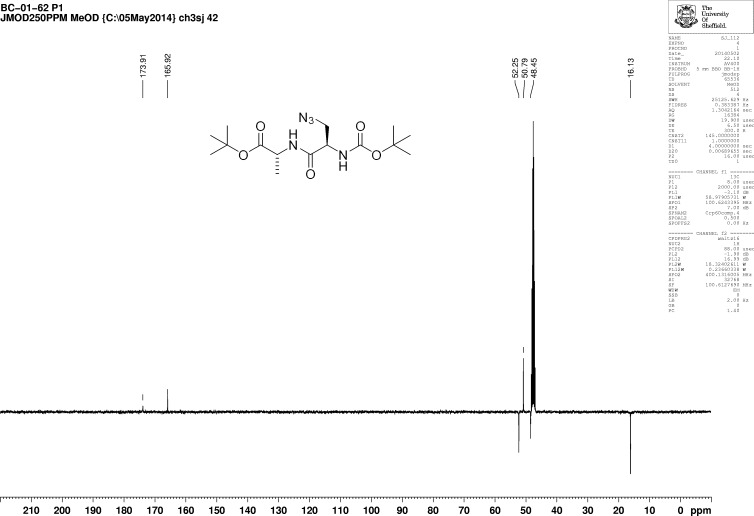
1D 13C NMR Spectrum of 3-Azido-N-[(1,1-dimethylethoxy)carbonyl]-D-alanyl-D-alanine 1,1-dimethylethyl ester (Boc-D-aza-ala-D-ala-OtBu).